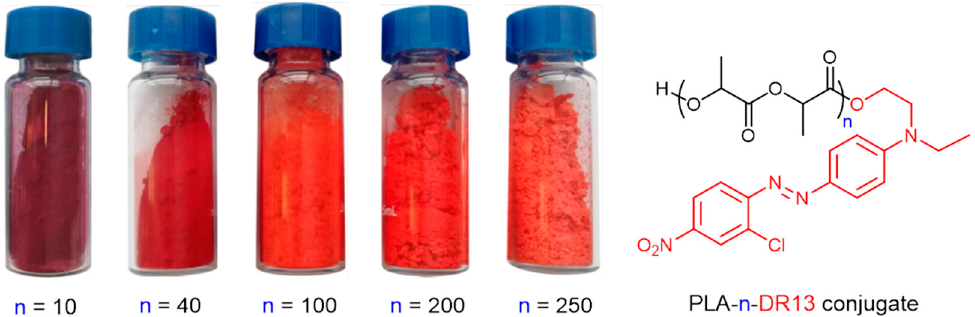
Figure 6. Polylactide (PLA)-n-DR1 conjugate samples with controlled molecular weights.